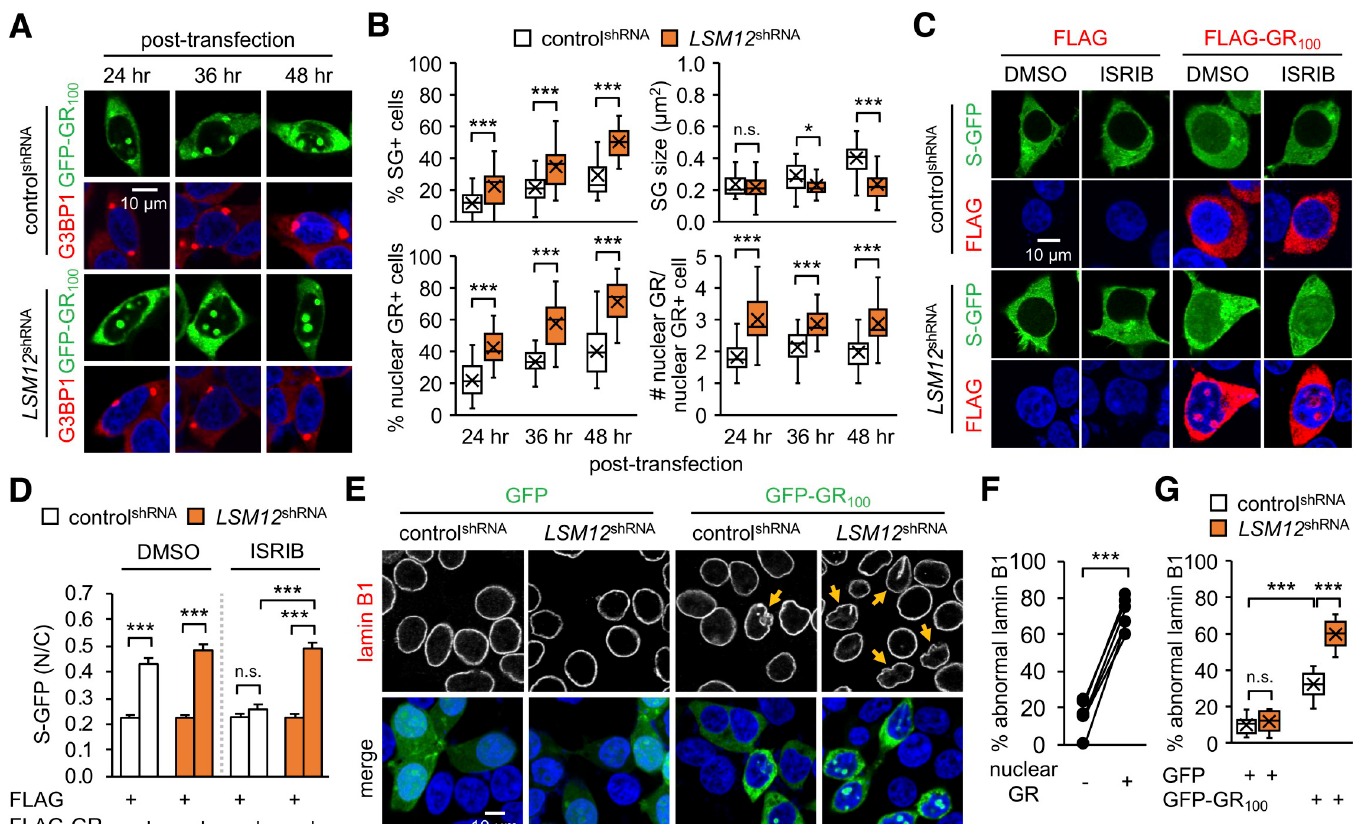
Fig 3. LSM12 depletion facilitates the nuclear accumulation of C9ORF72 -derived poly(GR) proteins and exacerbates their pathogenic effects. (A) LSM12 depletion suppresses the maturation of poly(GR)-induced SGs but promotes the nuclear accumulation of poly(GR) granules. Control shRNA and LSM12 shRNA cells were transfected with a GFP-GR 100 expression vector and then co-stained with anti-G3BP1 antibody (red) and Hoechst 33258 (blue) at the indicated time after transfection. (B) The assemblies of poly(GR)-induced SGs and nuclear poly(GR) granules were quantified as in Fig 1. Data represent means ± SEM ( n = 23–25 confocal images obtained from 3 independent experiments; n = 424–513 GFP-GR 100 –positive cells). n.s., not significant; � P < 0.05, ��� P < 0.001, as determined by Student t test. (C) ISRIB treatment suppresses the poly(GR)-induced disruption of NCT in control cells, but not in LSM12-depleted cells. Control shRNA and LSM12 shRNA cells were co-transfected with expression vectors for S-GFP and FLAG-GR 100 . Where indicated, cells were incubated with 2- μ M ISRIB or DMSO (vehicle control) for 5 hours and then co-stained with anti-FLAG antibody (red) and Hoechst 33258 (blue) 48 hours after transfection. (D) NCT of S-GFP reporter proteins was quantified as in Fig 2B. Data represent means ± SEM ( n = 142–166 cells from 3 independent experiments). n.s., not significant; ��� P < 0.001, as determined by 2-way ANOVA with Tukey post hoc test. (E) LSM12 depletion exacerbates poly(GR)-induced disruption of the nuclear lamina. Control shRNA and LSM12 shRNA cells were transfected with an expression vector for GFP or GFP-GR 100 and then co-stained with anti-lamin B1 antibody (red) and Hoechst 33258 (blue) to visualize nuclear envelope morphology 48 hours after transfection. Yellow arrows indicate GFP-GR 100 –positive cells with severe disruption of the nuclear lamina. (F) Control cells expressing GFP-GR 100 were scored for nuclear poly(GR) granules and abnormal morphology of the nuclear lamina. The relative percentages of cells with severe nuclear laminar disruption were averaged from confocal images of 6 random fields of interest per condition ( n = 55–69 GFP-GR 100 –positive cells from 3 independent experiments). Error bars indicate SEM. ��� P < 0.001, as determined by Student t test. (G) The relative percentages of control shRNA and LSM12 shRNA cells with severe nuclear lamina disruption were quantified as described above. Data represent means ± SEM ( n = 10 confocal images obtained from 3 independent experiments; n = 183–297 GFP–or GFP-GR 100 –positive cells). n.s., not significant; ��� P < 0.001, as determined by 2-way ANOVA with Tukey post hoc test. All underlying numerical values are available in S1 Data. ANOVA, analysis of variance; GFP, green fluorescent protein; LSM12, like-Sm protein 12; N/C, nuclear to cytoplasmic; NCT, nucleocytoplasmic transport; SEM, standard error of the mean; SG, stress granule; shRNA, short hairpin.